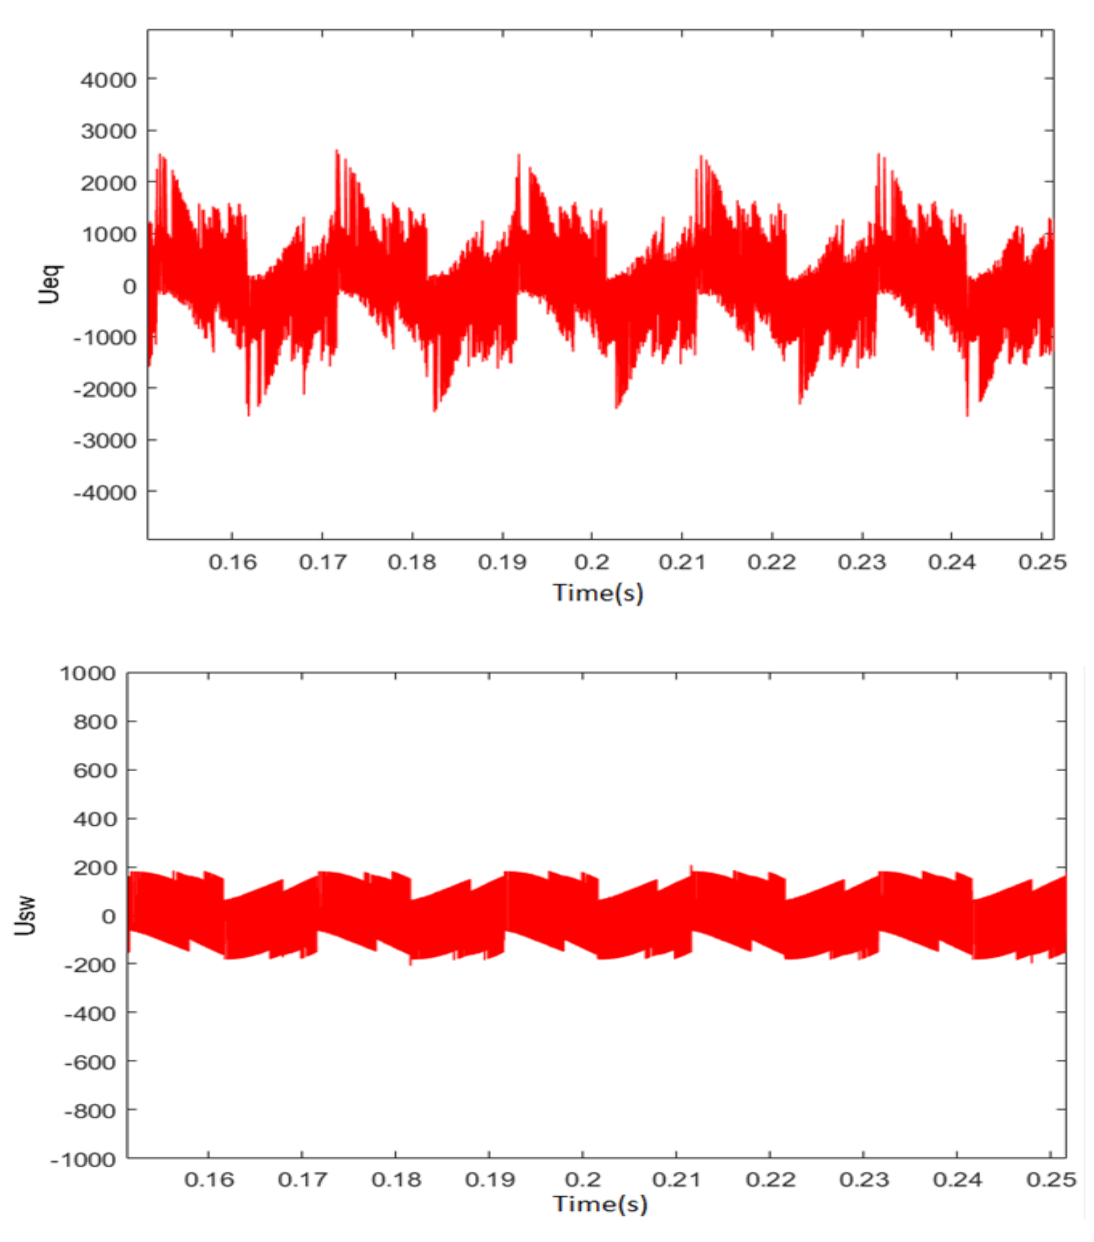
Figure 9. Comparison of u eq and u sw .